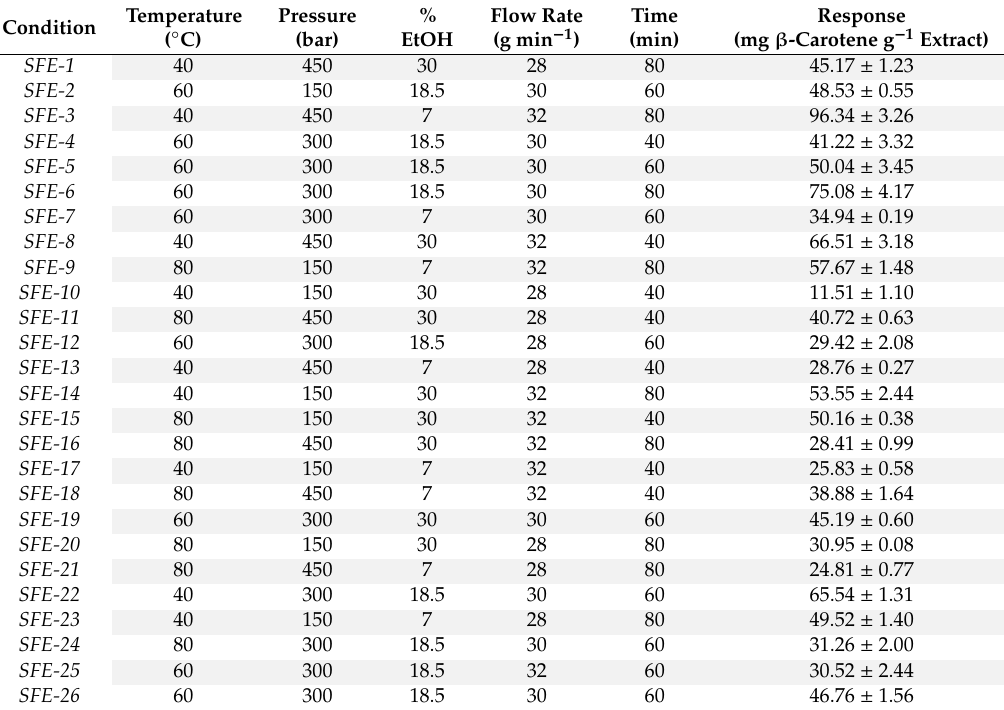
Table 1. Values of independent factors used for the central composite design and response values. Data are given as the mean ± SD of two